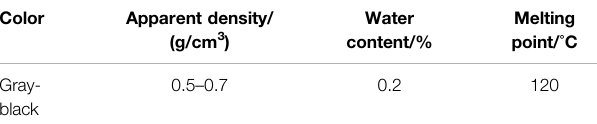
TABLE 6 | Physical indices of